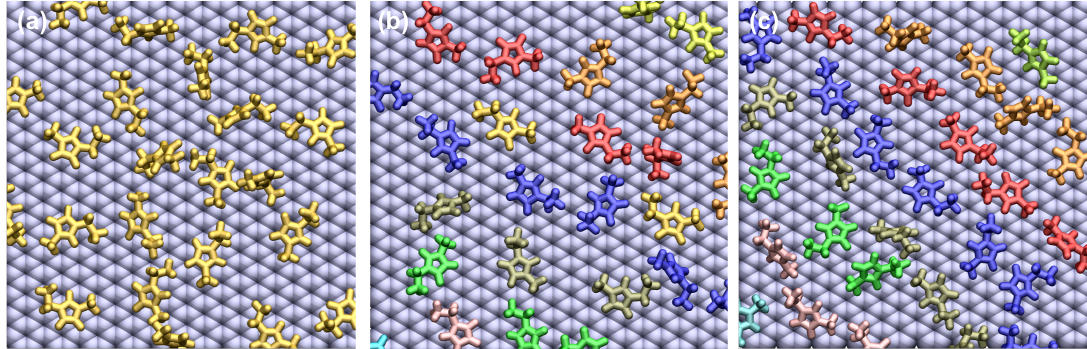
Figure 9. A snapshot of [C 2 mim] + ions with any atom within 4 Å from the electrode surface at ( a ) Ψ − = 0 V, ( b ) Ψ − = − 0.5 V and ( c ) Ψ − = − 2 V. Each colour in ( b , c ) represents a different